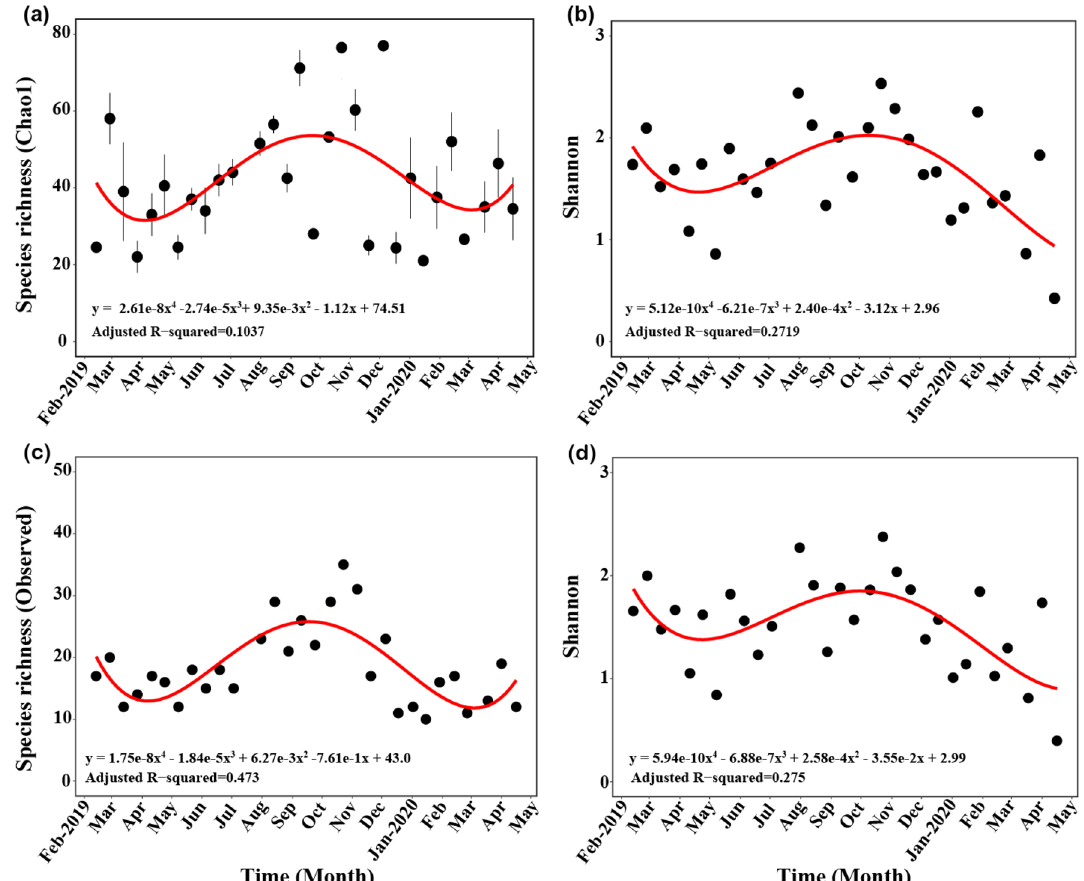
Figure 2. Temporal distribution of the α-diversity (species richness and Shannon index). ( a ) Chao1 index for “total” zooplankton species. ( b ) Shannon diversity index for “total” zooplankton. ( c ) Observed species richness for “common” zooplankton. ( d ) Shannon diversity index for “common” zooplankton. Standard errors and the regression lines are indicated by the vertical and red lines. Figures were produced using R (v4.0.3, https:// www.R- proje ct.